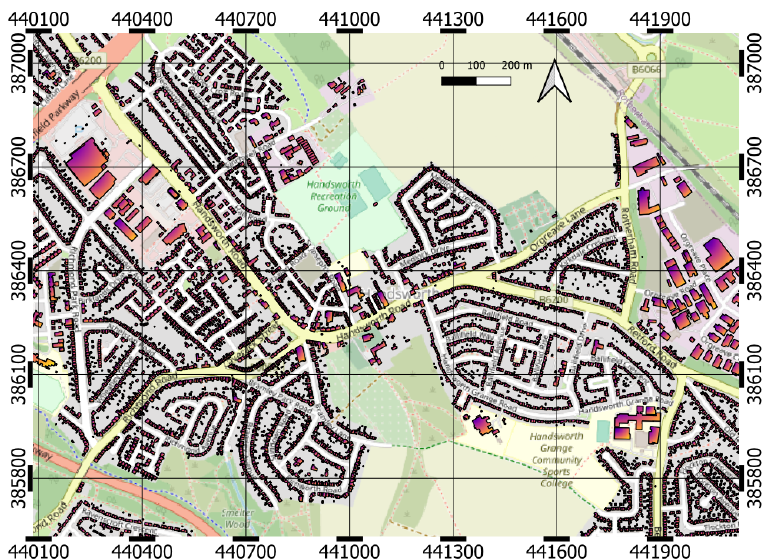
Figure 3. Map of the data capture area. This area is a typical suburb in northern England, which is located in Handsworth, Sheffield. A total of 5906 images are collected in this area and manually annotated to build the semantic segmentation dataset.